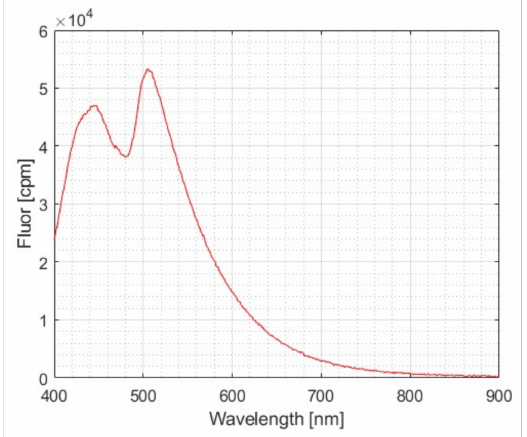
Figure 1. PL spectrum of liquid PA Si-QDs dissolved in DCM measured on FS5 spectrofluorometer.